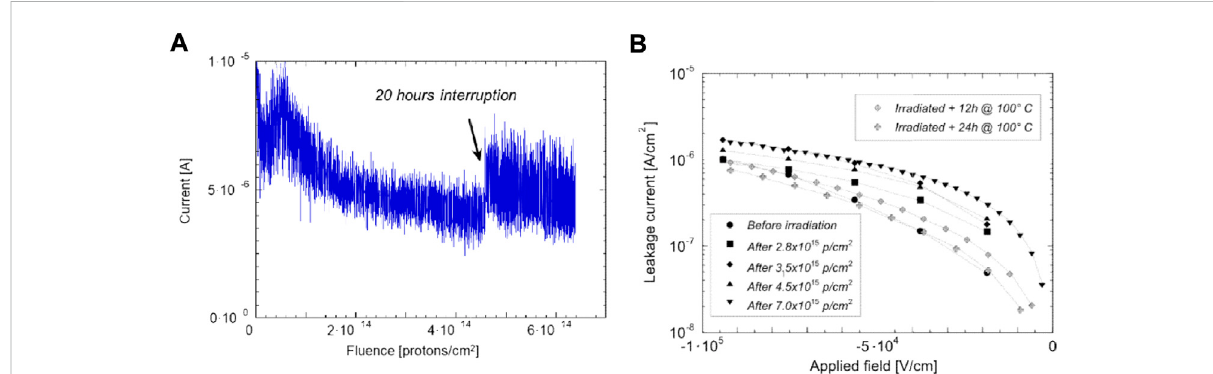
FIGURE 1 (A) Detectorcurrentversusproton fl uenceina32 µmthicka-Si:Hp-i-nsensoratconstantdoserate(1.3×10 11 protons/spill,300 Vbias)at4.5× 10 14 protons/cm 2 there was a 20 h beam interruption, where the effect of auto-annealing can be noticed. (B) Leakage current versus applied fi eld in the same detector at various fl uencies and after 12 and 24 h of annealing at 100 ° C and 300 V bias [13].